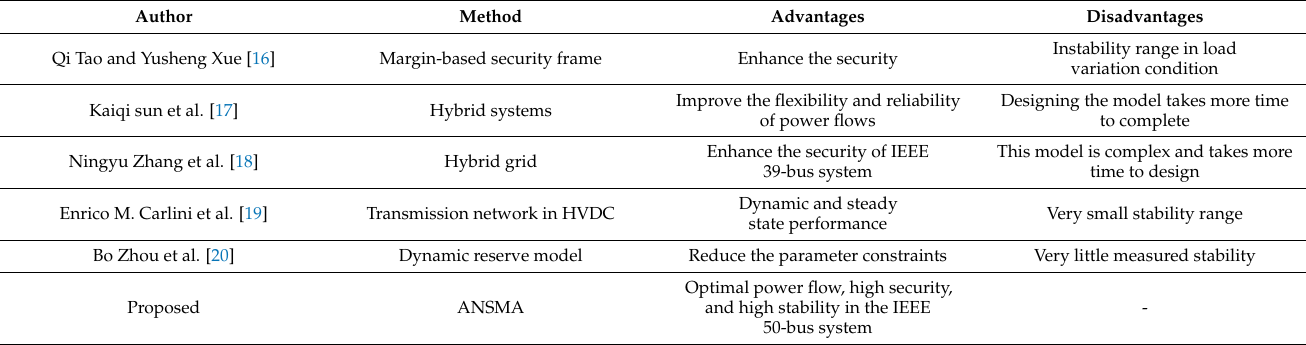
Table 3. State-of-the-art methods compared with proposed